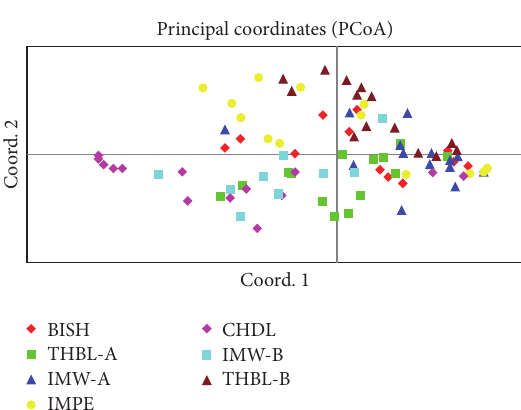
Figure 6: Two-dimensional plot of principal coordinate analysis (PCoA) showing clustering of individual samples belonging to 7 populations of M. baccifera. cases the surviving individuals are effectively sampled from the populations that have existed before. The existence of significant genetic variation within the populations of M.